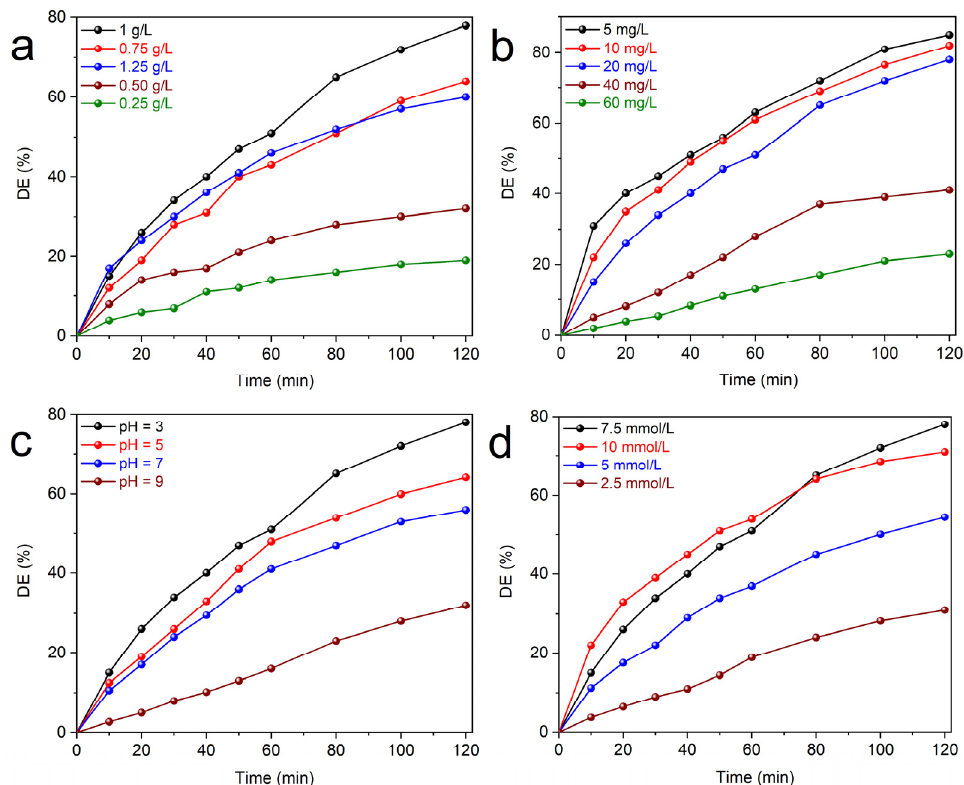
Figure 3. Effect of ( a ) Cu–THAp amount, ( b ) initial RhB concentration, ( c ) pH, and ( d ) PDS concentration on PDS activation for RhB degradation. (Operational conditions: (Cu–THAp) 0 = 1 g/L, (RhB) 0 = 20 mg/L, (PDS) = 7.5 mmol/L, and pH = 3).